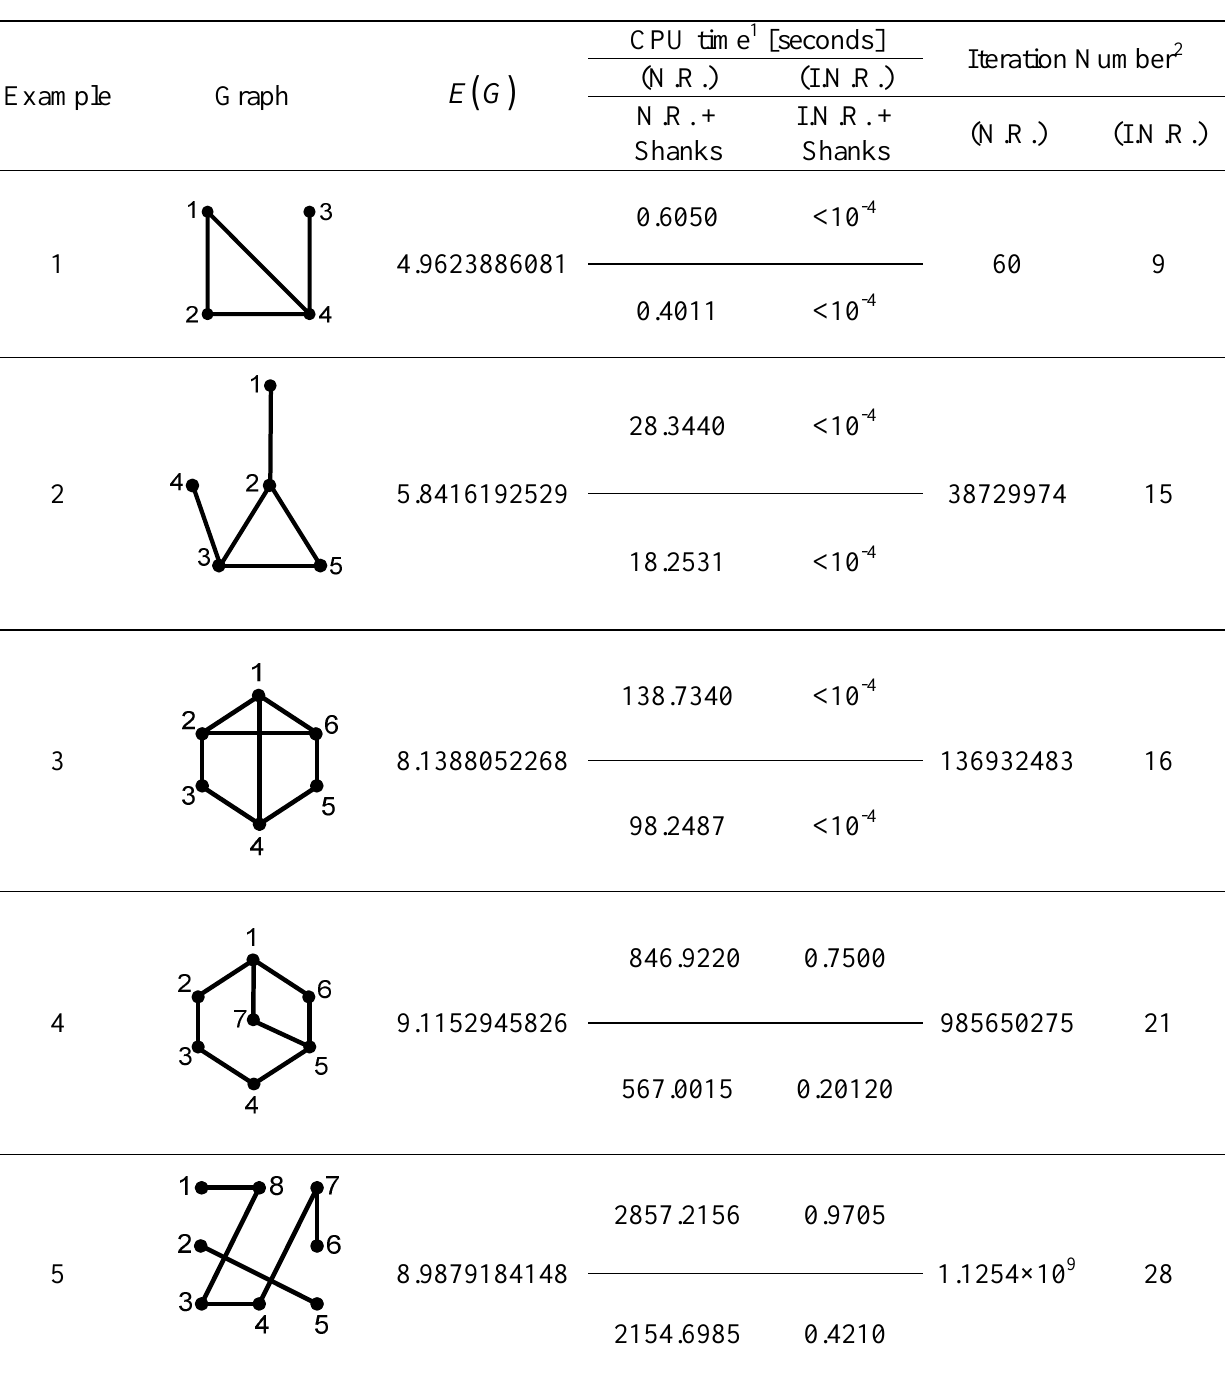
Table 1. Results of five numerical examples obtained by the N.R. and the I.N.R. algorithms. 1 The simulations have been performed by a PC with a 2.66 GHz processor and 2.00 GB of RAM; 2 For the same value of the initial guess and a tolerance of 10 -20